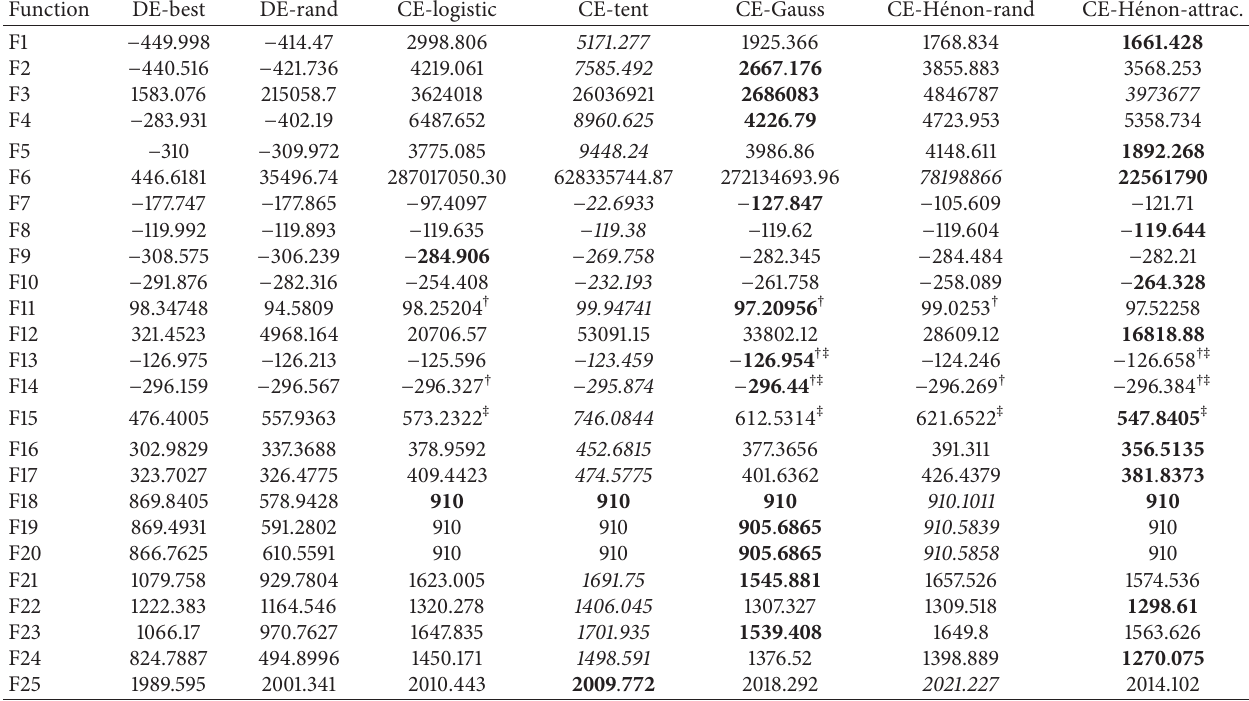
Table 3: Mean fitness values of F1–F25 with 10D. The fitness values in bold and italic font are the best and worst optimization results among the five chaotic evolution algorithms, respectively. The ( † ) and ( ‡ ) marks mean that they are significantly better than or as the same as DE/best/1/bin and DE/rand/1/bin, respectively, by Wilcoxon sign-ranked test ( 𝑃 < 0.05 ).